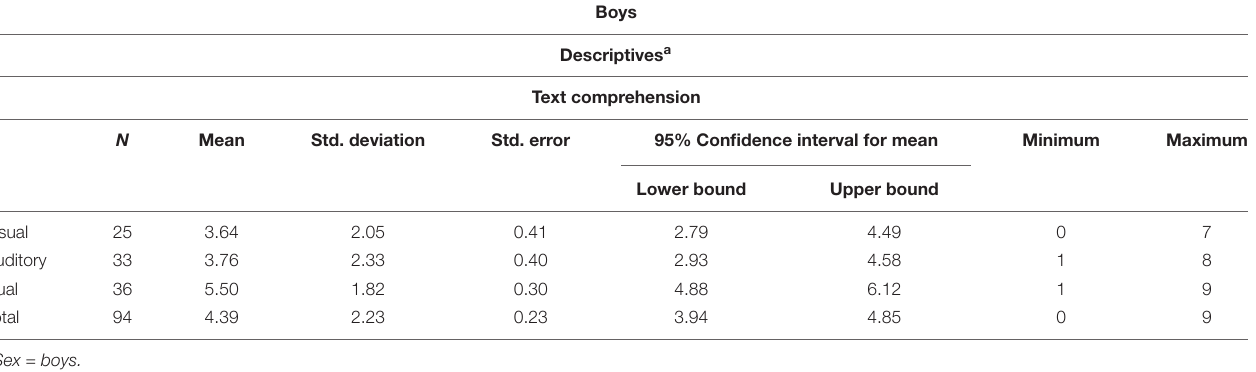
TABLE 2 | Descriptive and multiple comparisons of text comprehension by presentation modality by